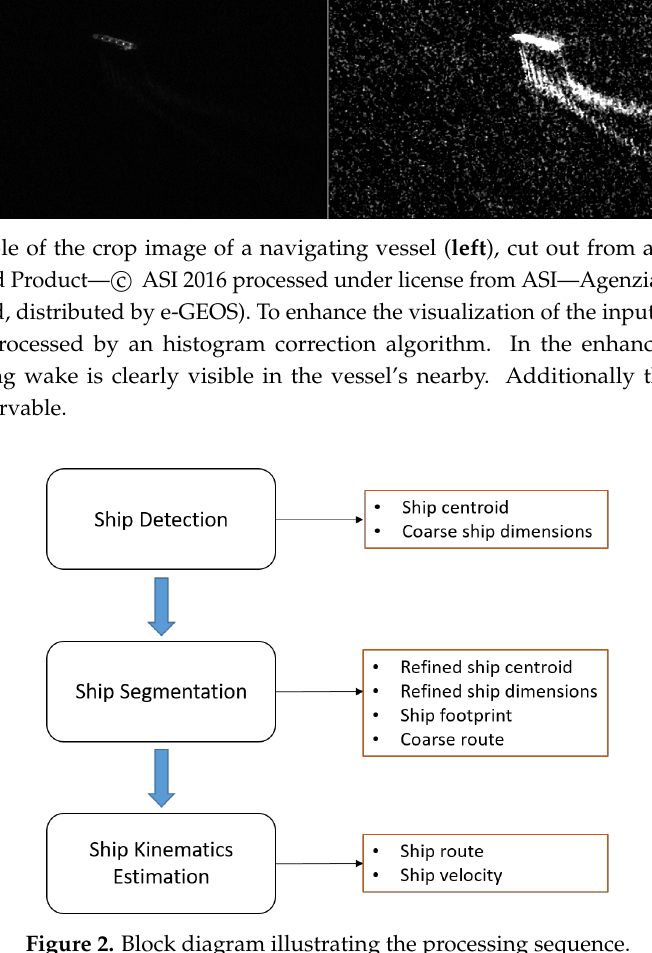
Figure 2. Block diagram illustrating the processing